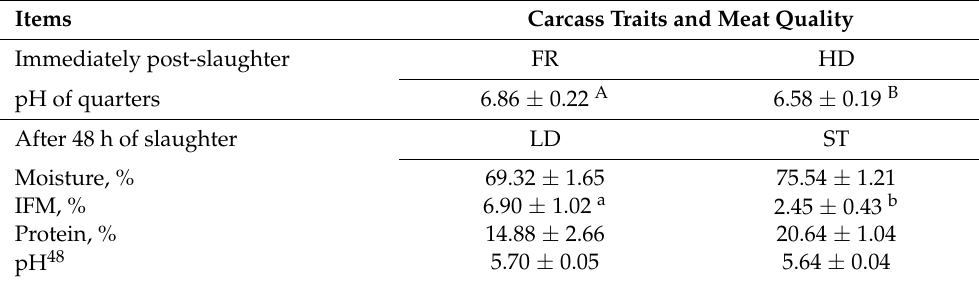
Table 1. Carcass traits and proximate composition of Longissimus dorsi (LD) and Semitendinosus (ST) Charolais muscles after 48 h of slaughter (mean value ± S.D; n = 3/muscle). Carcass Traits and Meat